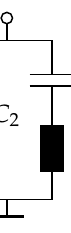
Figure 3. Resonant/anti-resonant LC